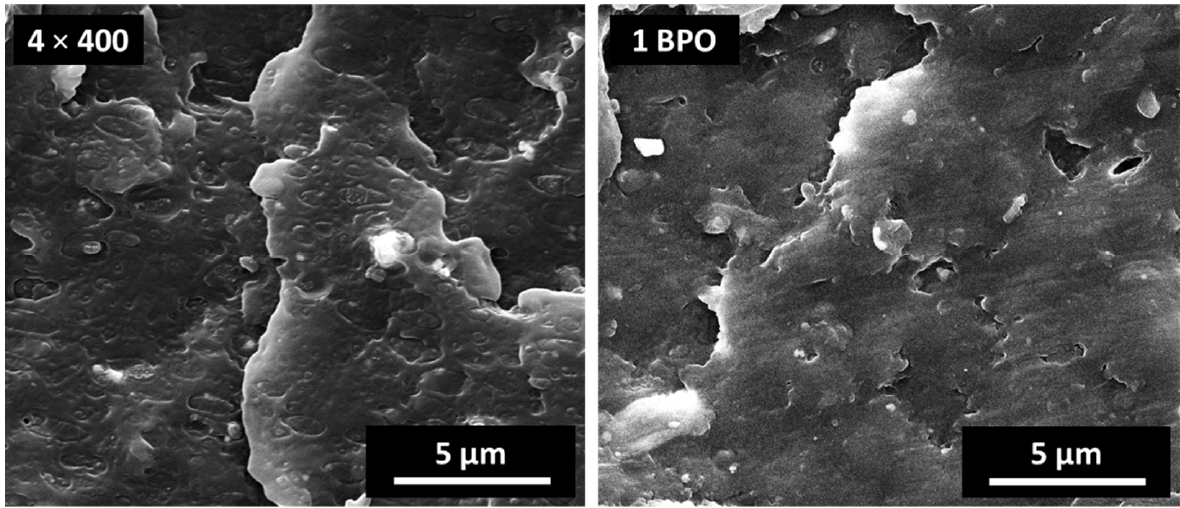
Figure 4. SEM micrographs of cryo-fractured surfaces of 4 × 400 and 1 BPO (2 + 2) × 400 samples.